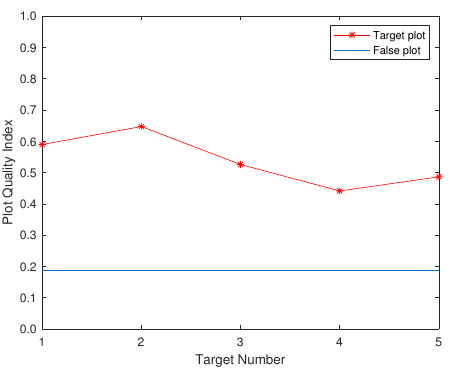
Figure 12. Comparison of the average plot quality indexes between moving vessel and false